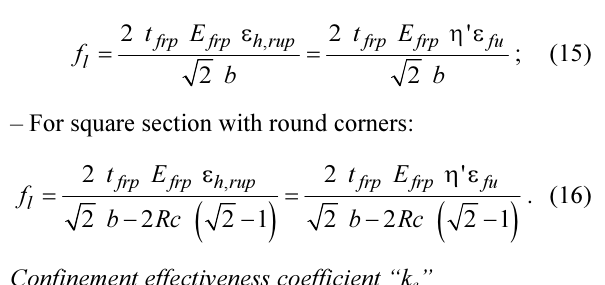
Fig. 15. Strengthening ratio vs. confinement ratio and strain enhancement ratio vs. confinement ratio for the test results of this